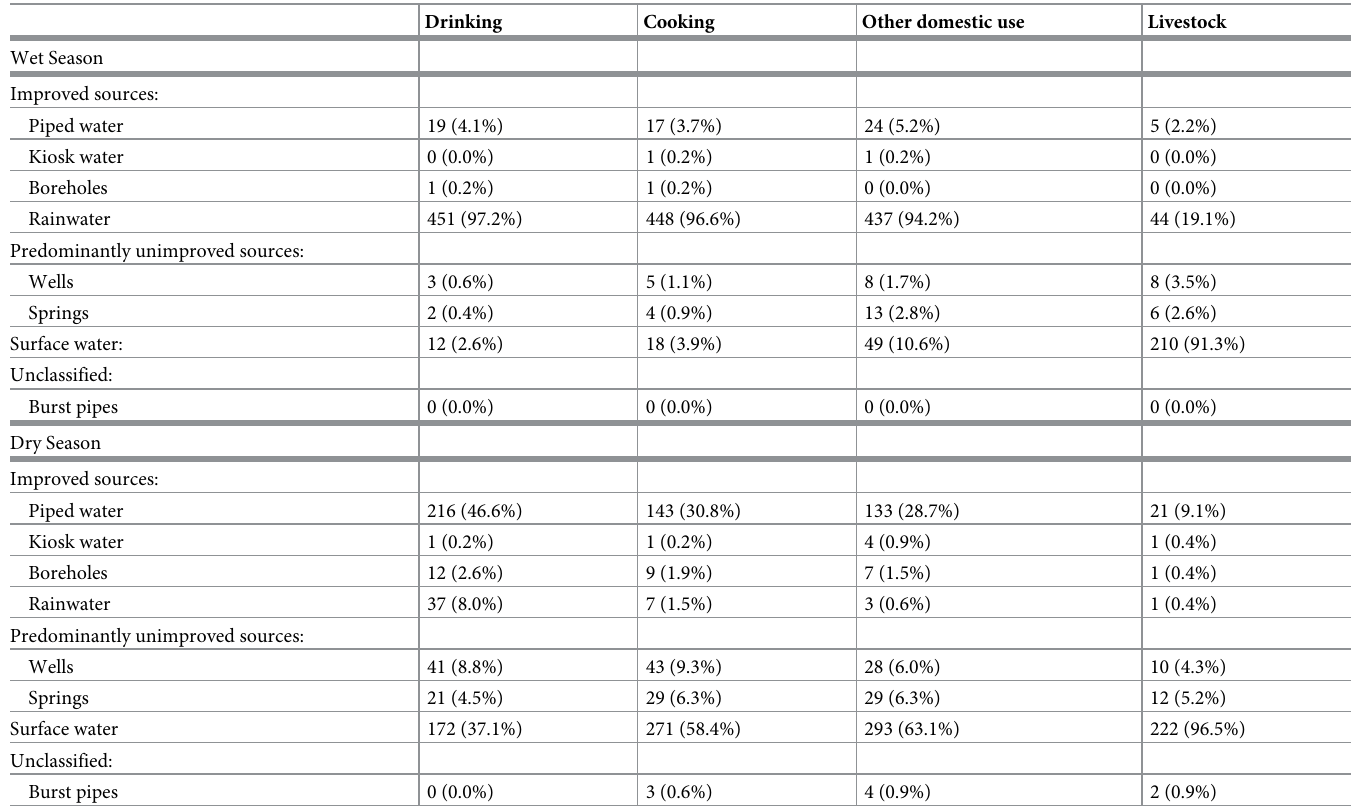
Table 3. Water source use, reported via two questionnaire survey visits (comprising 438 responses from 234